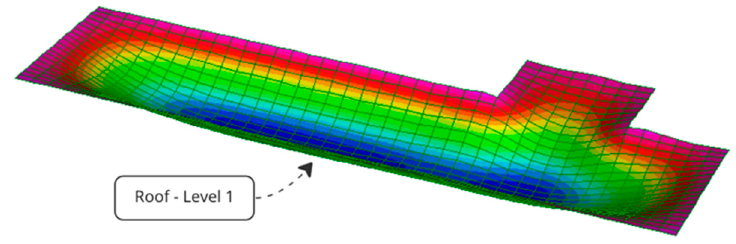
Figure 18. Deformed shape of the first floor influenced by the dead and live loads.